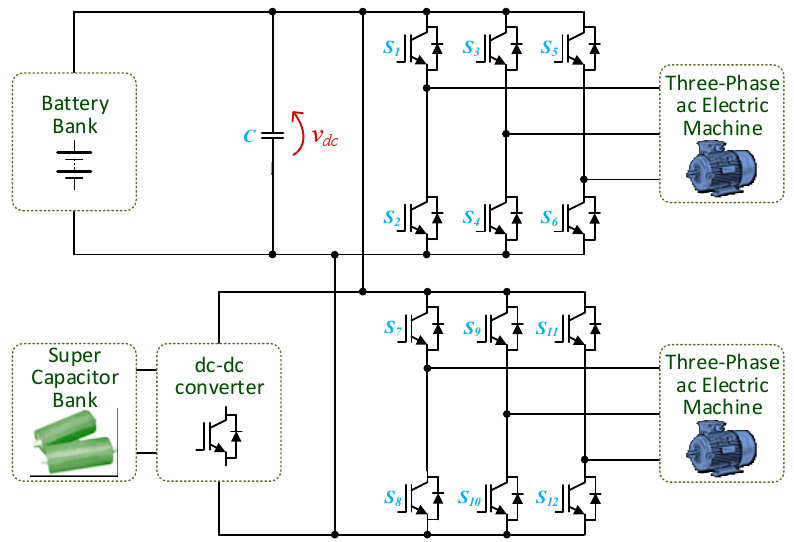
Figure 37. Traction system for an electric bus based on two three-phase ac electric machines and super capacitors for energy recovery.